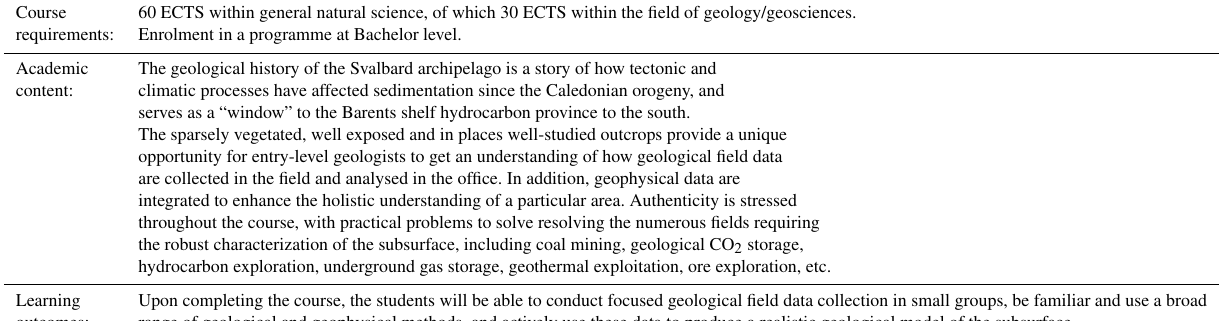
Table A1. Key parameters of the presented AG222